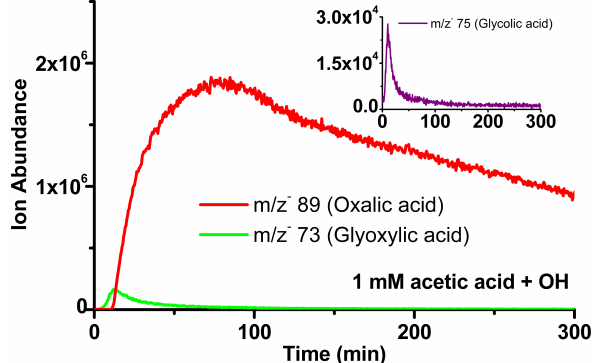
Fig. 1. ESI-MS online analysis of 1mM acetic acid+OH radical experiment.